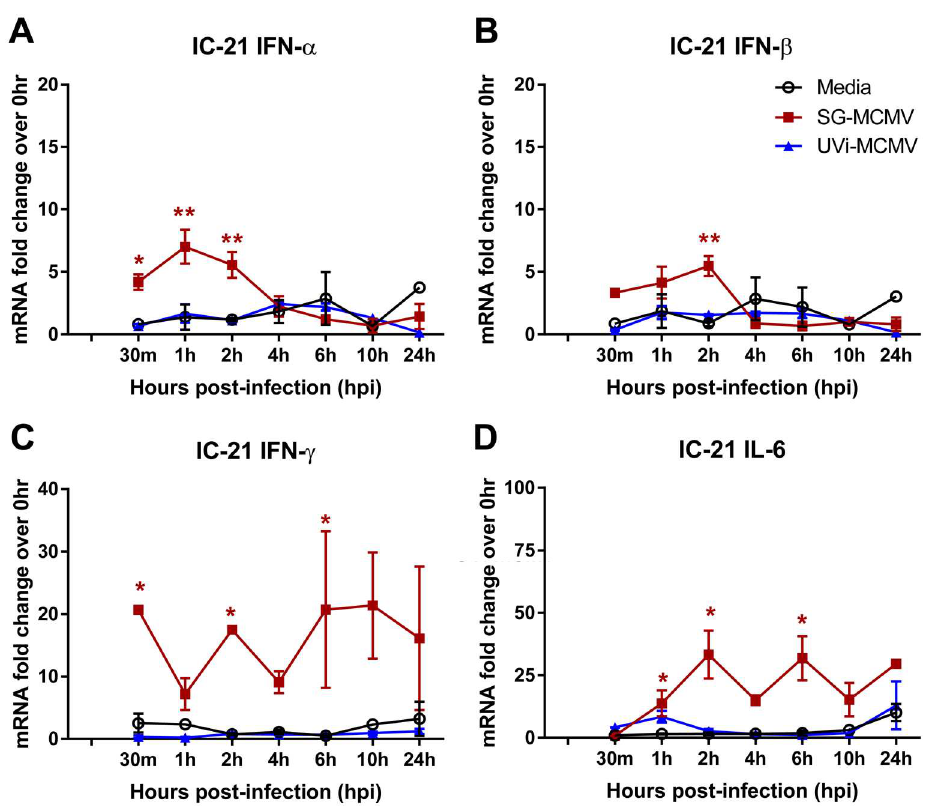
Fig 6. Infection of mouse macrophages with SG-MCMV, but not UV-inactivated SG-MCMV, stimulates cytokines known to induce SOCS1 and SOCS3. Monolayersof IC-21 mouse macrophages were treated with media (control), infected with MCMV at MOI = 3 PFU/cell, or treated with an equal volume of UVi-MCMV. Cells were harvested at indicatedtime points and assessedby real-time RT-PCR assay using the comparative 2 - ΔΔ Ct method for IFN- α (A) , IFN- β (B) , IFN- γ (C) , or IL-6 (D) mRNA transcripts, with all samples comparedback to the media group at 0 hpi. Means ± SD of at least duplicateexperimental repeats are shown. * p < 0.05, ** p < 0.01,and *** p < 0.001,comparedwith respectivemedia controls at the same time